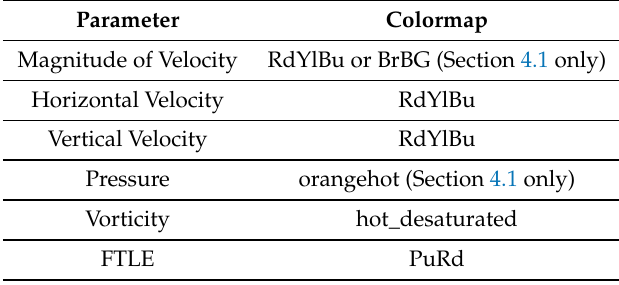
Table 2. Colormaps used for each scalar variable for